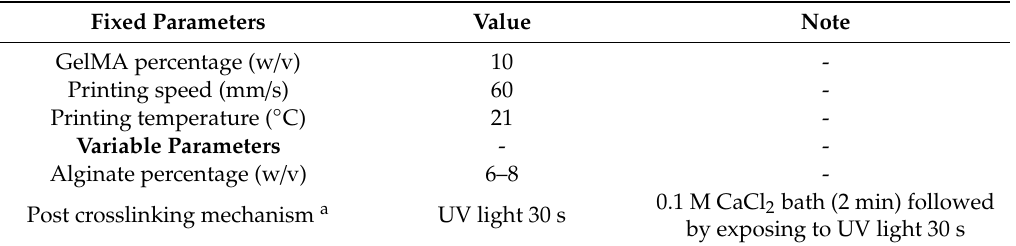
Table 1. Parameters for bioprinting cell-laden GelMA-alginate